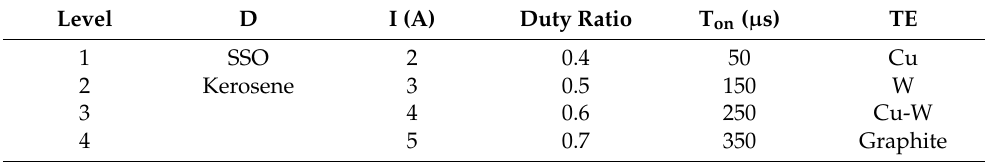
Table 3. Orthogonal experimental design with 1 factor under 2 levels and 4 factors under 4